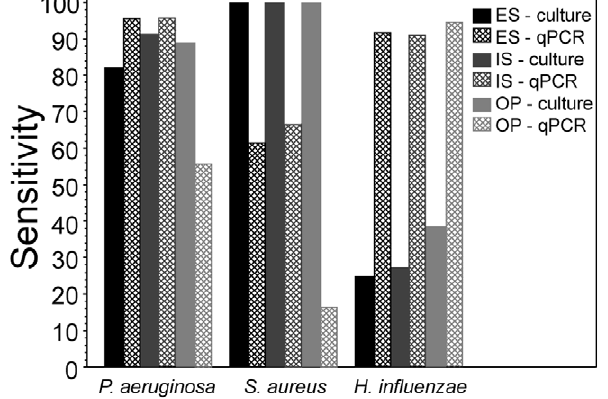
Figure 4. Sensitivity of qPCR and culture compared to a composite gold-standard for P. aeruginosa , S. aureus , and H. influenzae . (N=122 specimens) ES= expectorated sputum, IS= induced sputum, OP= oropharyngeal swab. doi:10.1371/journal.pone.0015101.g004 PLoS ONE |